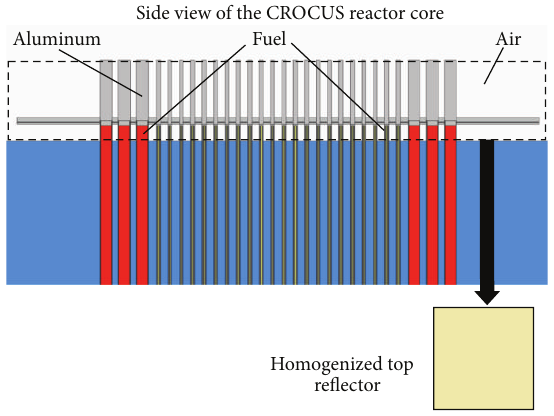
Figure 6: Top reflector cross-sections generation.